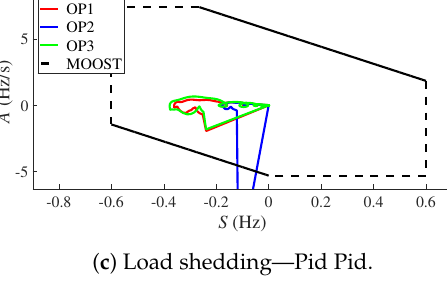
Figure 15. A k ( S k )